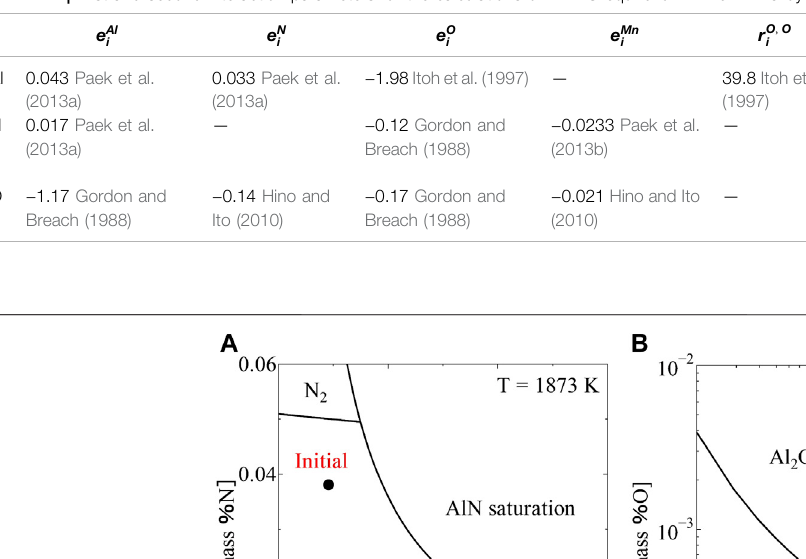
TABLE 2 | First and second interaction parameters for the calculations of Al-N-O equilibrium in FeAlMn alloy at 1873K.